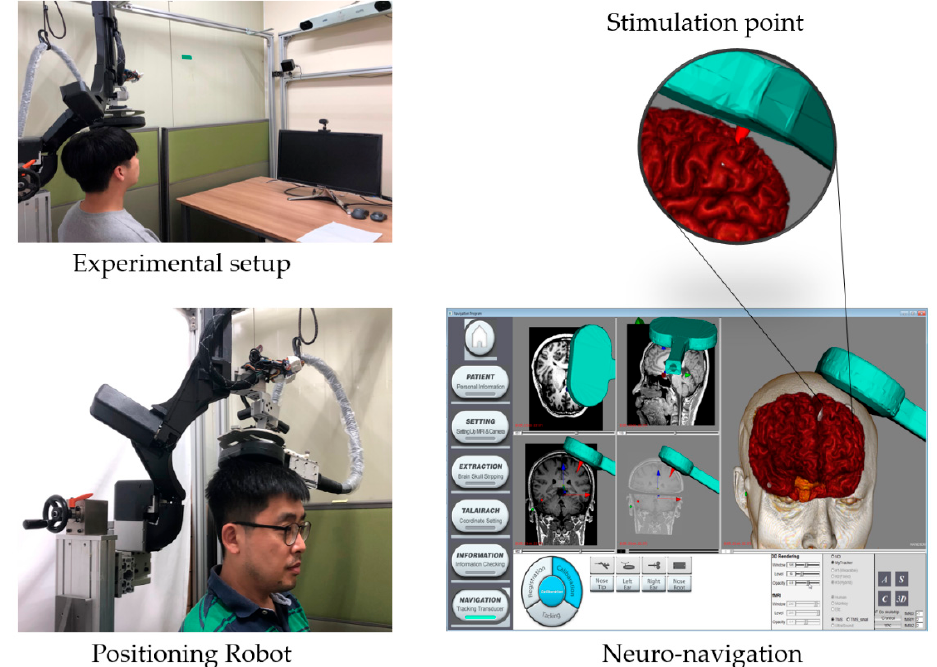
Figure 1. Developed system for non ‐ invasive brain stimulation.